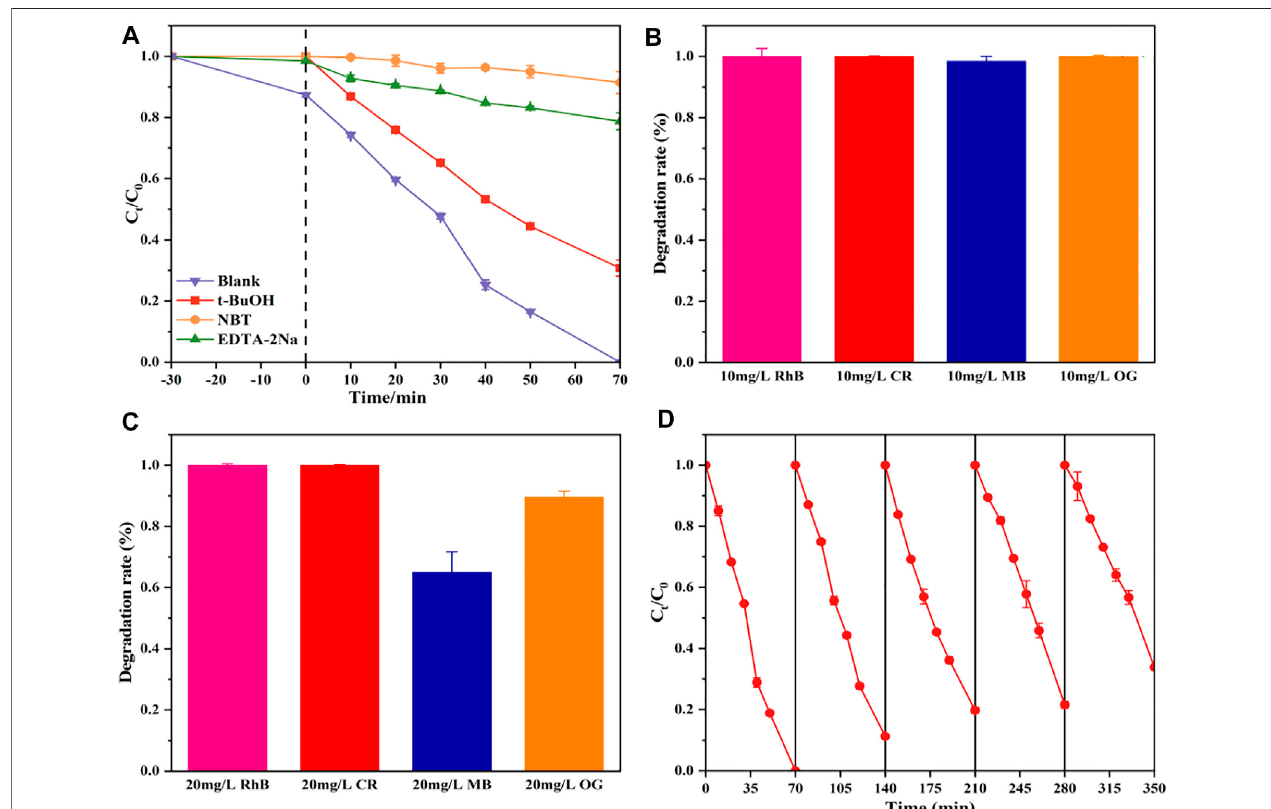
FIGURE 6 | Photocatalytic activities of the TNT-400-Pt sample for RhB degradation with disparate scavengers (A) , photocatalytic degradation of different dyes within 70 min by TNT-400-Pt at an initial concentration of 10 mg/L (B), and 20 mg/L (C) , fi ve cycles of degradation of TNT-400-Pt (D) .